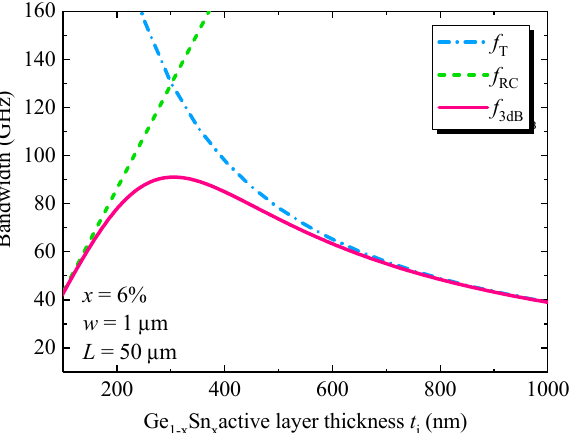
Figure 6. Calculated transit-time-delay-limited BW, RC-delay-limited BW and 3-dB BW as a function of Ge 1 − x Sn x active layer thickness.